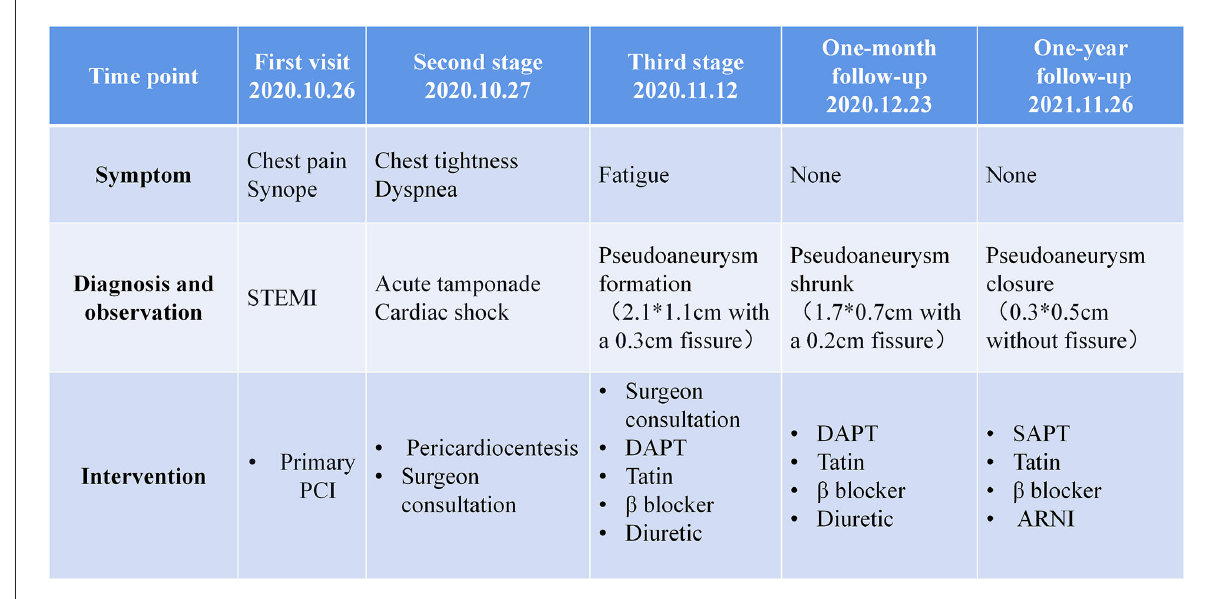
FIGURE2 Clinical diagnosis and treatment timeline of the patient. STEMI, ST-segment elevation myocardial infarction; PCI, percutaneous coronary intervention; DAPT, dual-antiplatelet therapy; SAPT, single antiplatelet therapy; ARNI, angiotensin receptor, and neprilysin